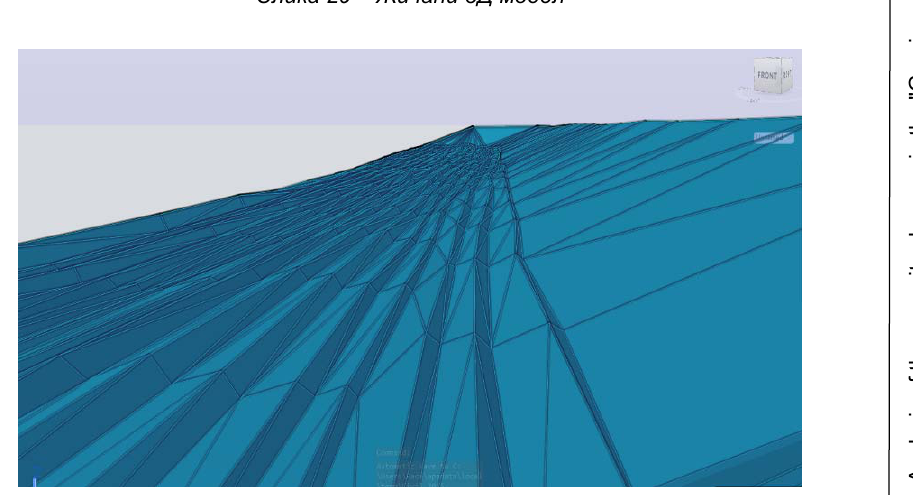
Figure 29 – Wired 3D model Рис . 29 – Каркасная 3 Д модель Слика 29 – Жичани 3 Д модел